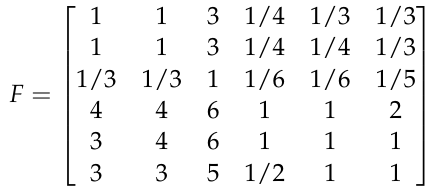
Table 6. The passing times of the effect.